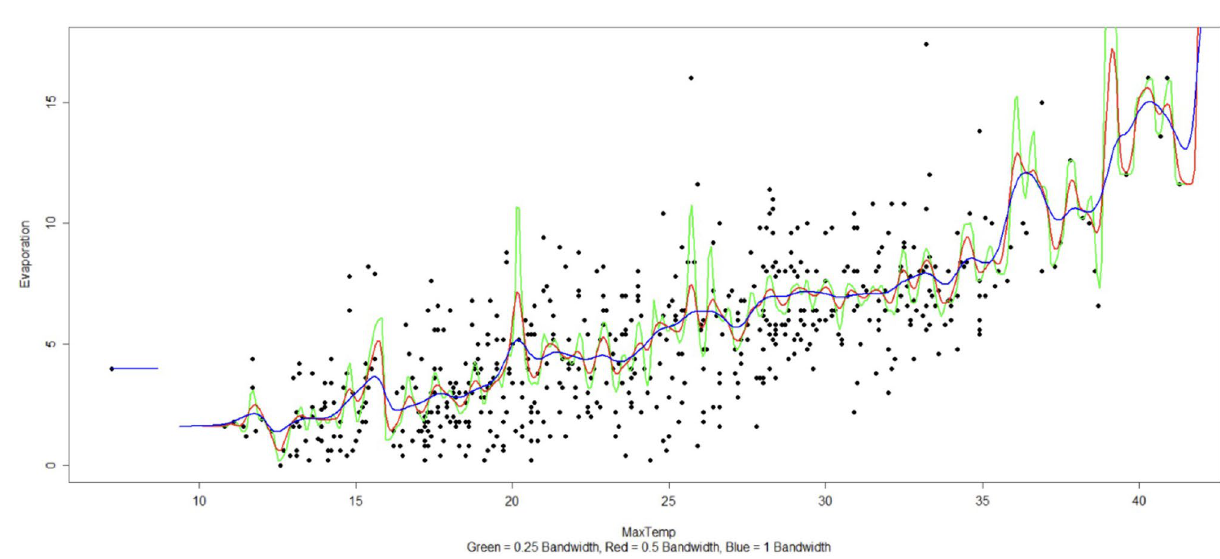
Figure 8. Boxplots between significant